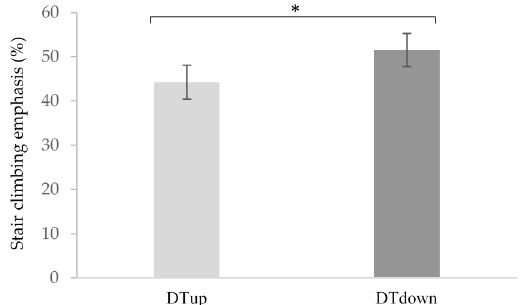
Figure 6. Participant responses to the subjective emphasis question. Participants reported focusing significantly more on stair climbing during stair descent (DT down ) compared to ascent (DT up ) t (19) = − 2.214, p = 0.039. (*) indicates significance p < 0.05 and error bars represent standard error of the mean.